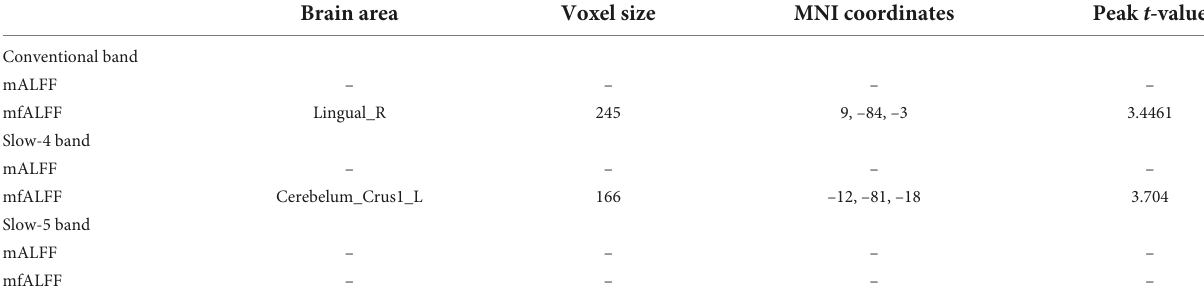
TABLE 2 Regions showing abnormal ALFF and fALFF in LDH-pre compared with